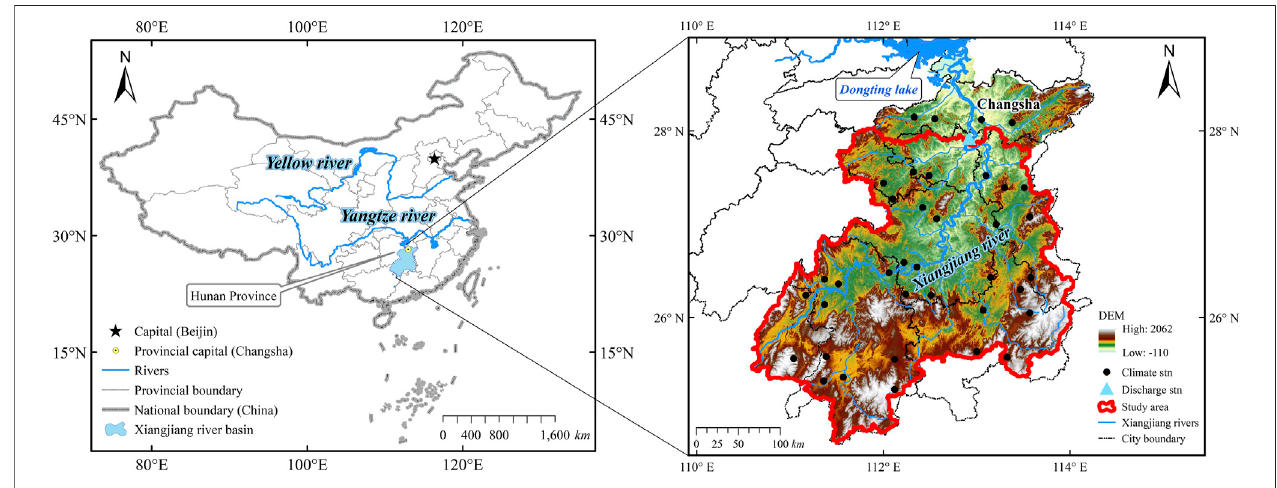
FIGURE 1 | Location of the Xiangjiang River Basin,